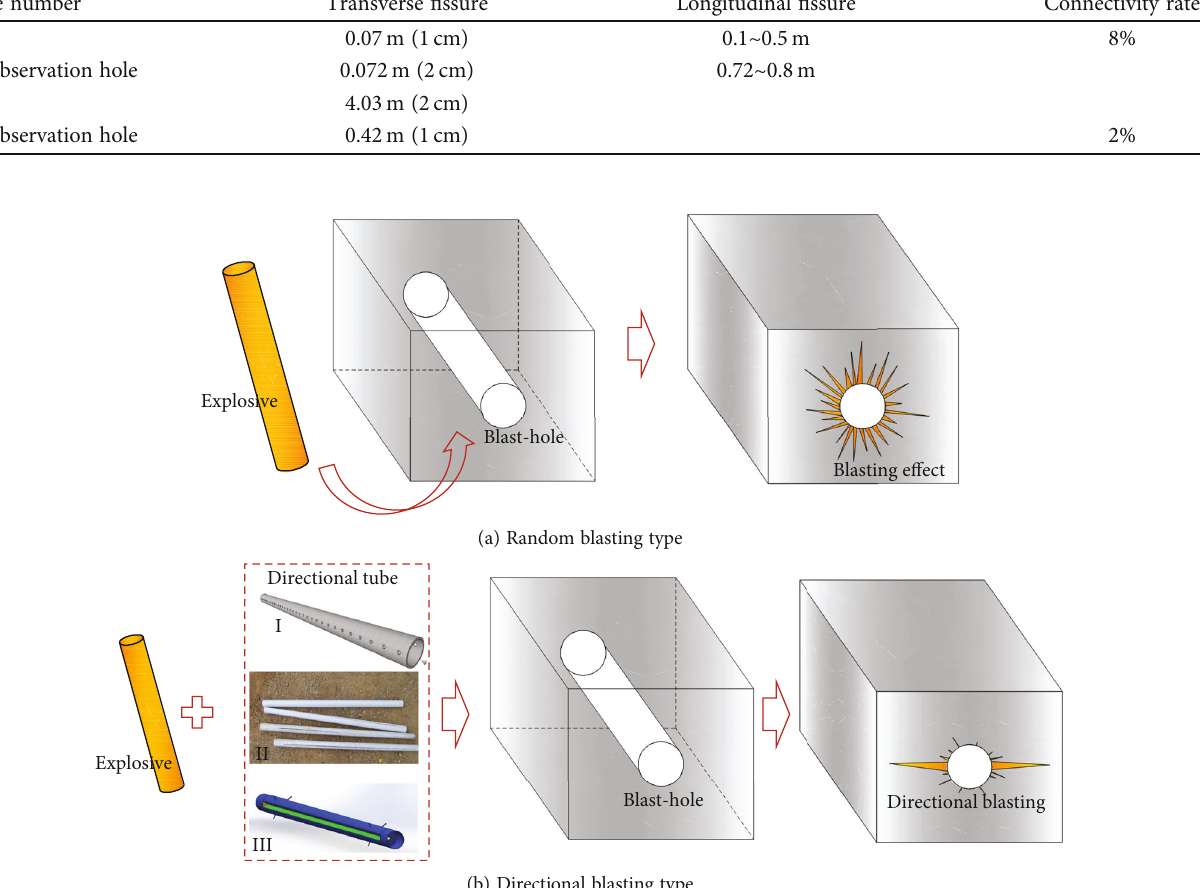
Figure 10: Blasting method and its e ff ect diagram.